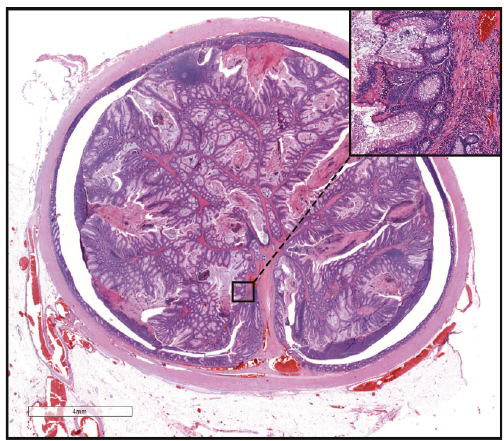
Figure 2: H and E sections of appendiceal lesion at low magni- fication (1X) show pedunculated polyp with arborizing bands of fibromuscular tissue (20X), distending appendiceal